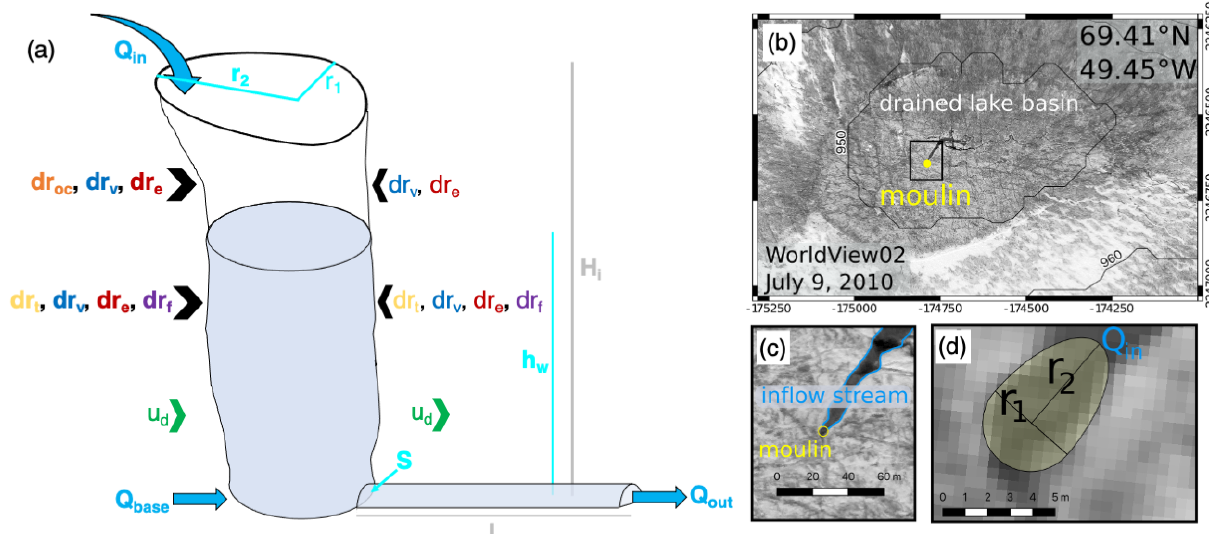
Figure 2. MouSh geometry and surface expression of a moulin and its reflection in the MouSh model. (a) Schematic of MouSh geometry and inputs. Inflow and outflow of the system are indicated by Q in , Q out , and Q base . Time-evolving moulin and subglacial parameters include moulin radii ( r 1 ,r 2 ), moulin water level ( h w ), and subglacial cross-sectional area ( S ). r 1 and r 2 are evolved by d r oc , d r v , d r e , d r f , and d r t (open-channel melting, viscous deformation, elastic deformation, refreezing, and turbulent melting, respectively; colored as in Fig. 1). u d shears the moulin as prescribed by Glen’s flow law. Ice thickness and subglacial path length are indicated by H i and L , respectively. Ice flow is from left to right. Modified from Trunz (2021). (b) WorldView-2 scene from July 2010 of an approximately 1.2km × 0 . 8km region surrounding the example moulin (yellow) formed by a drained supraglacial lake. (c) Detail of panel (b) , with the inflow stream and moulin indicated. (d) Detail of panel (c) , showing the moulin minor radius r 1 , major radius r 2 , and water input Q in from the inflow stream, as represented in the MouSh model. Maps generated by authors. WorldView image © 2010 DigitalGlobe, Inc.